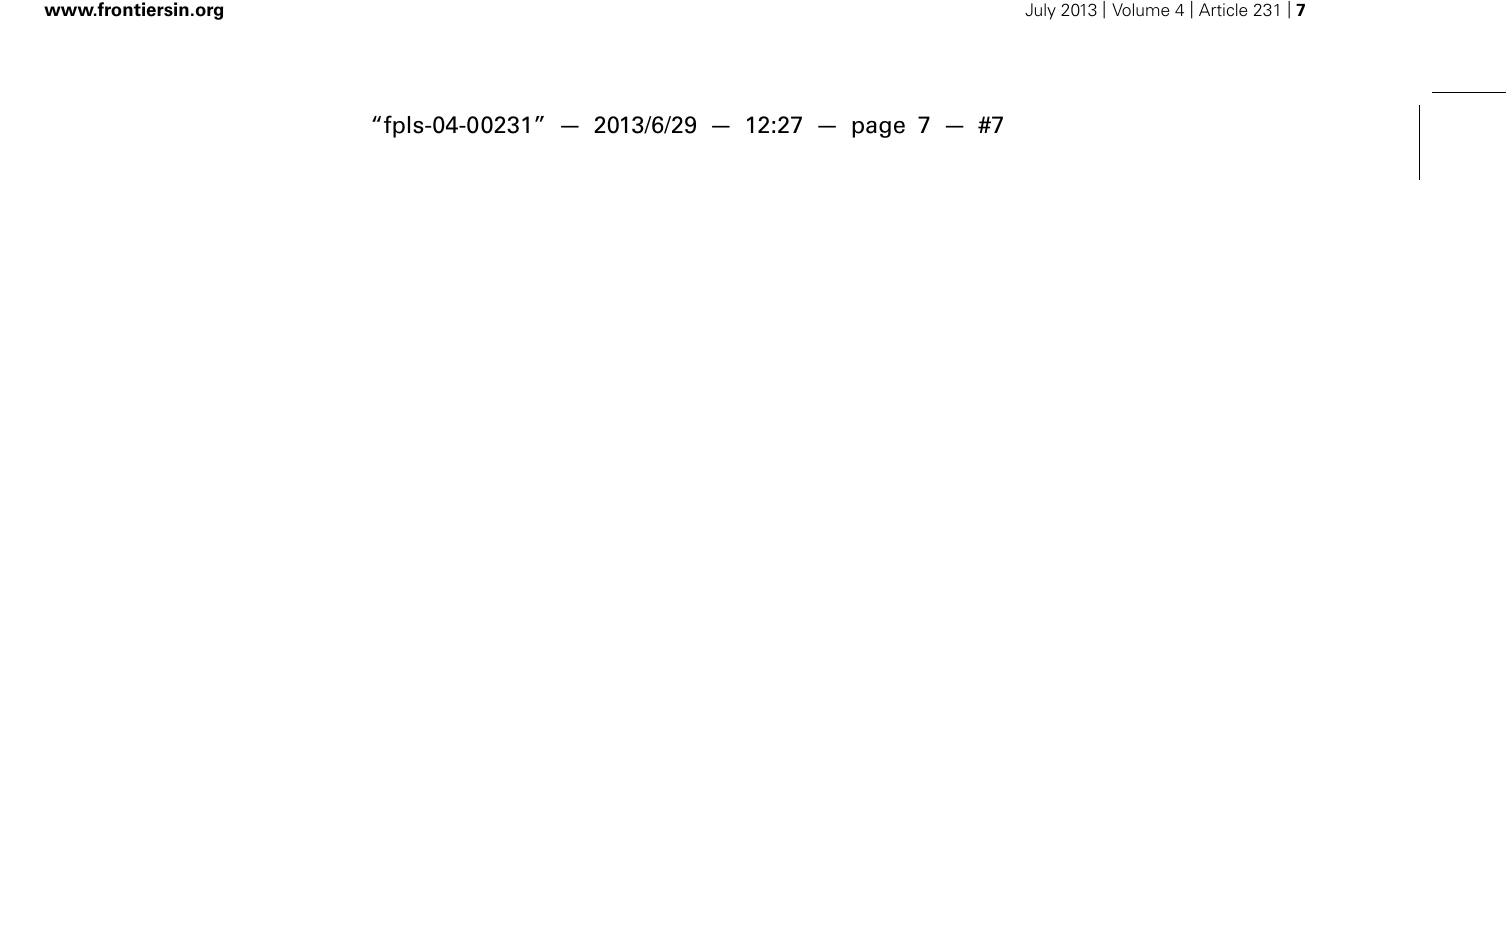
FIGURE 2 | Overview of carbon transport proteins in sink organs. Transport steps in sieve elements and sink cells are depicted according to their respective mode of action. Squares represent antiporters, circles describe facilitators, pentagons depict symporters, hexagons represent ABC transporters, and triangles H + -ATPases/PPases. 2, pGlcT; 3, MEX; 4,TMT and VGT; 7, SWEETs; 10, GPT; 11, BASS2; 12, PPT, 13, DiT2; 14, NTT; 15, ABCA9;